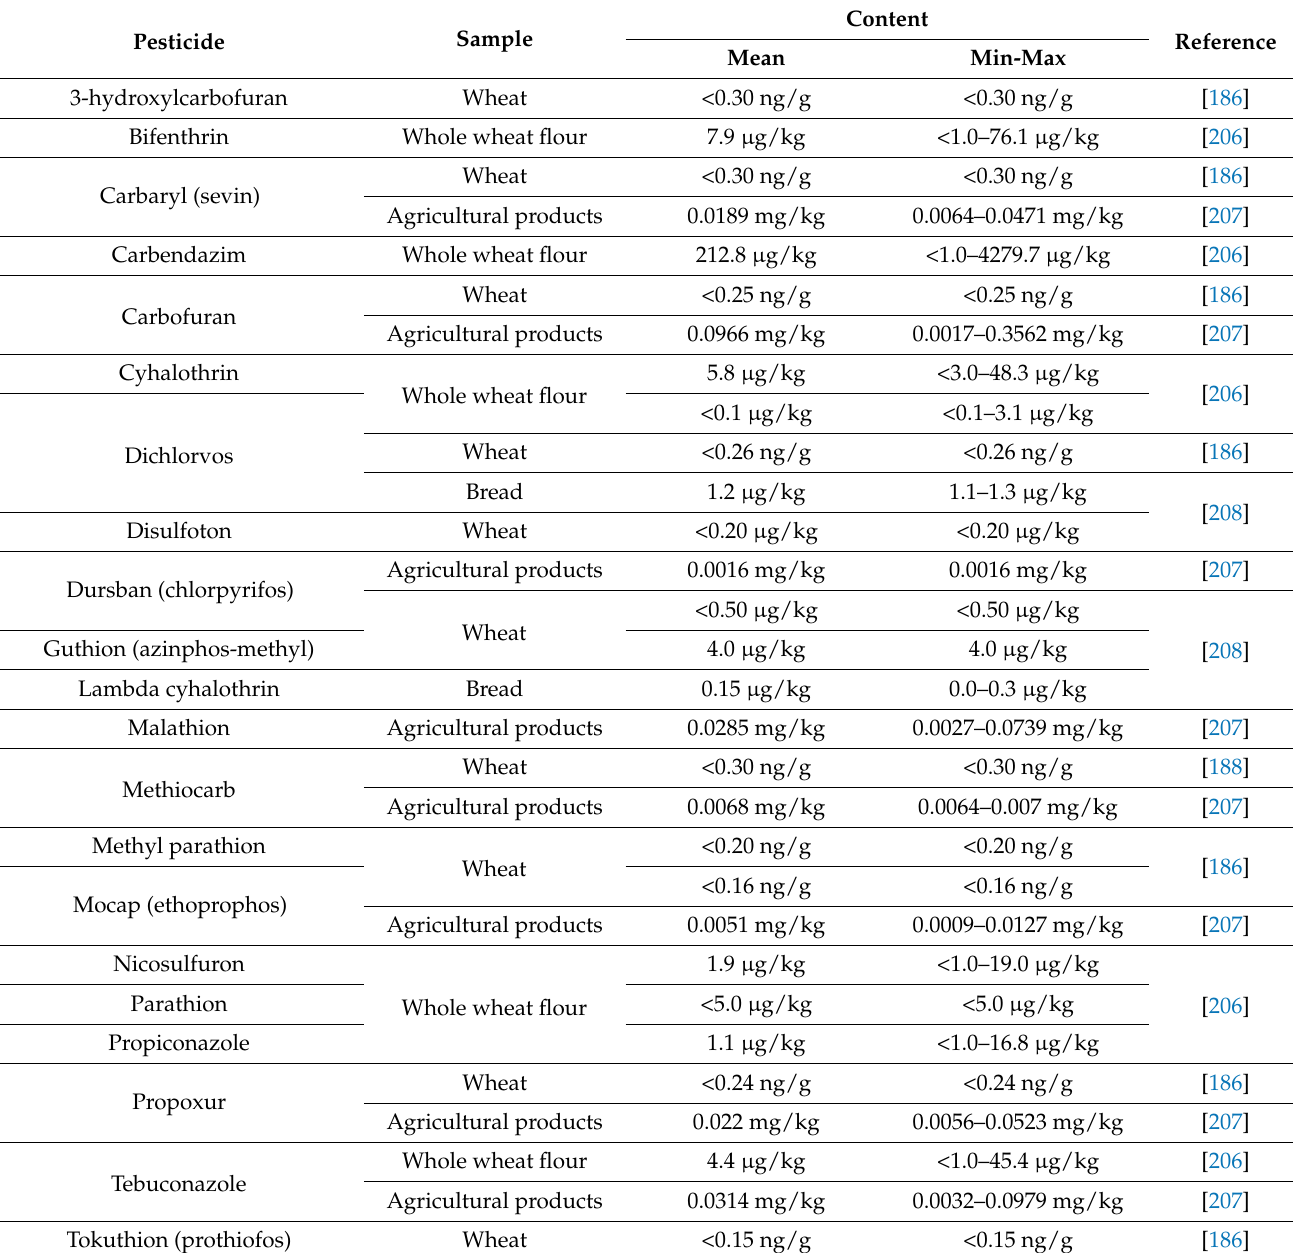
Table 7. Newest pesticides’ ubiquity in wheat-based